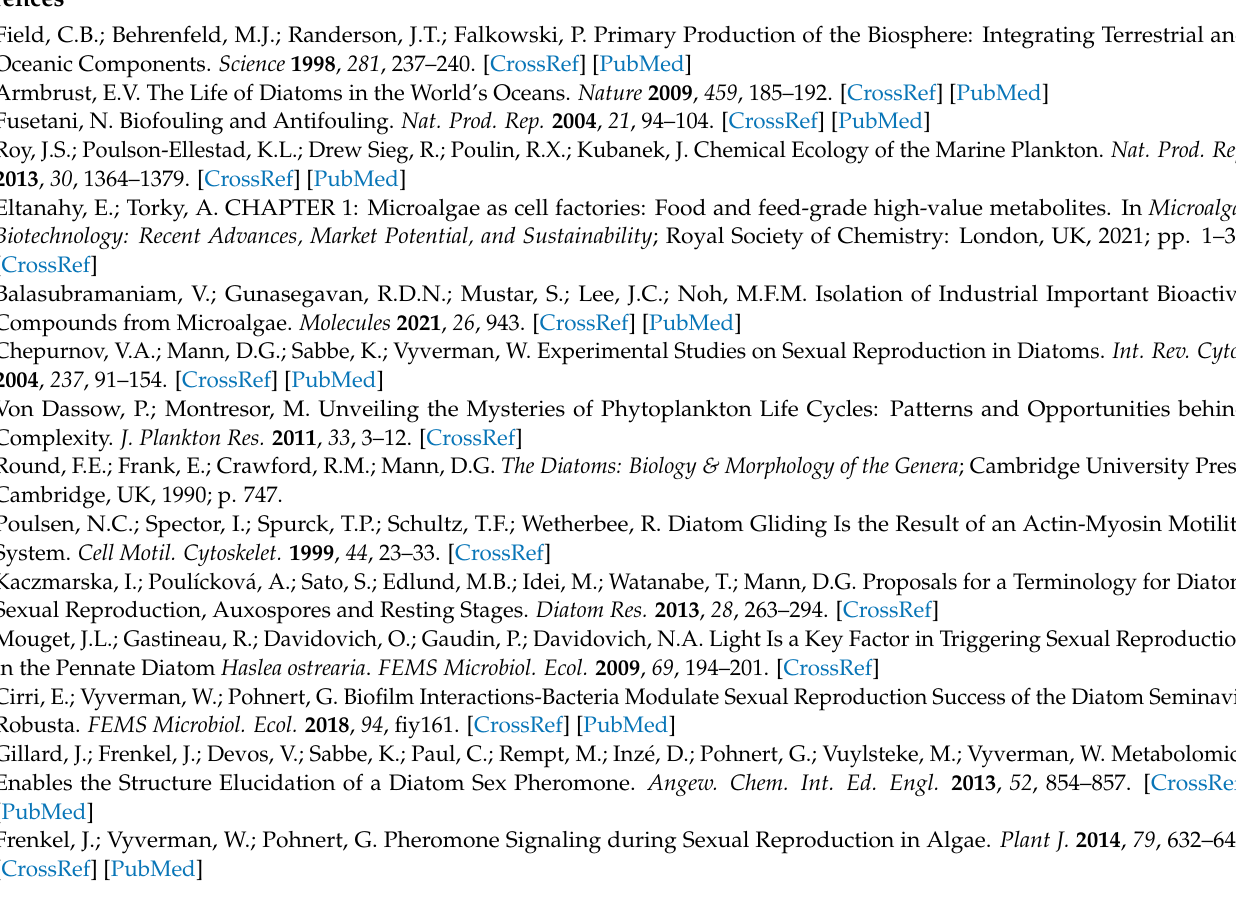
Figure S3: Chemical–physical characterization of P. multistriata pheromones; Figure S4: Scheme of the MRP1 construct and screening of the resistant clones; Table S1: List of the strains used; Table S2: List of the primers used; Table S3: Complete table of all the target